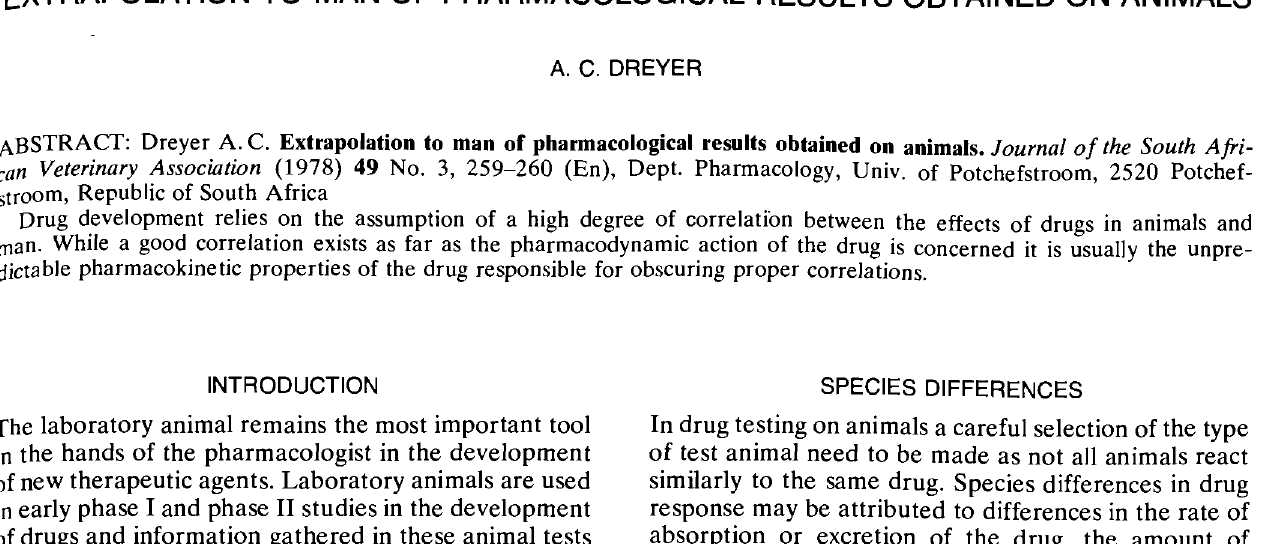
Table 1: COMPOUNDS ELIMINATED WITHOUT